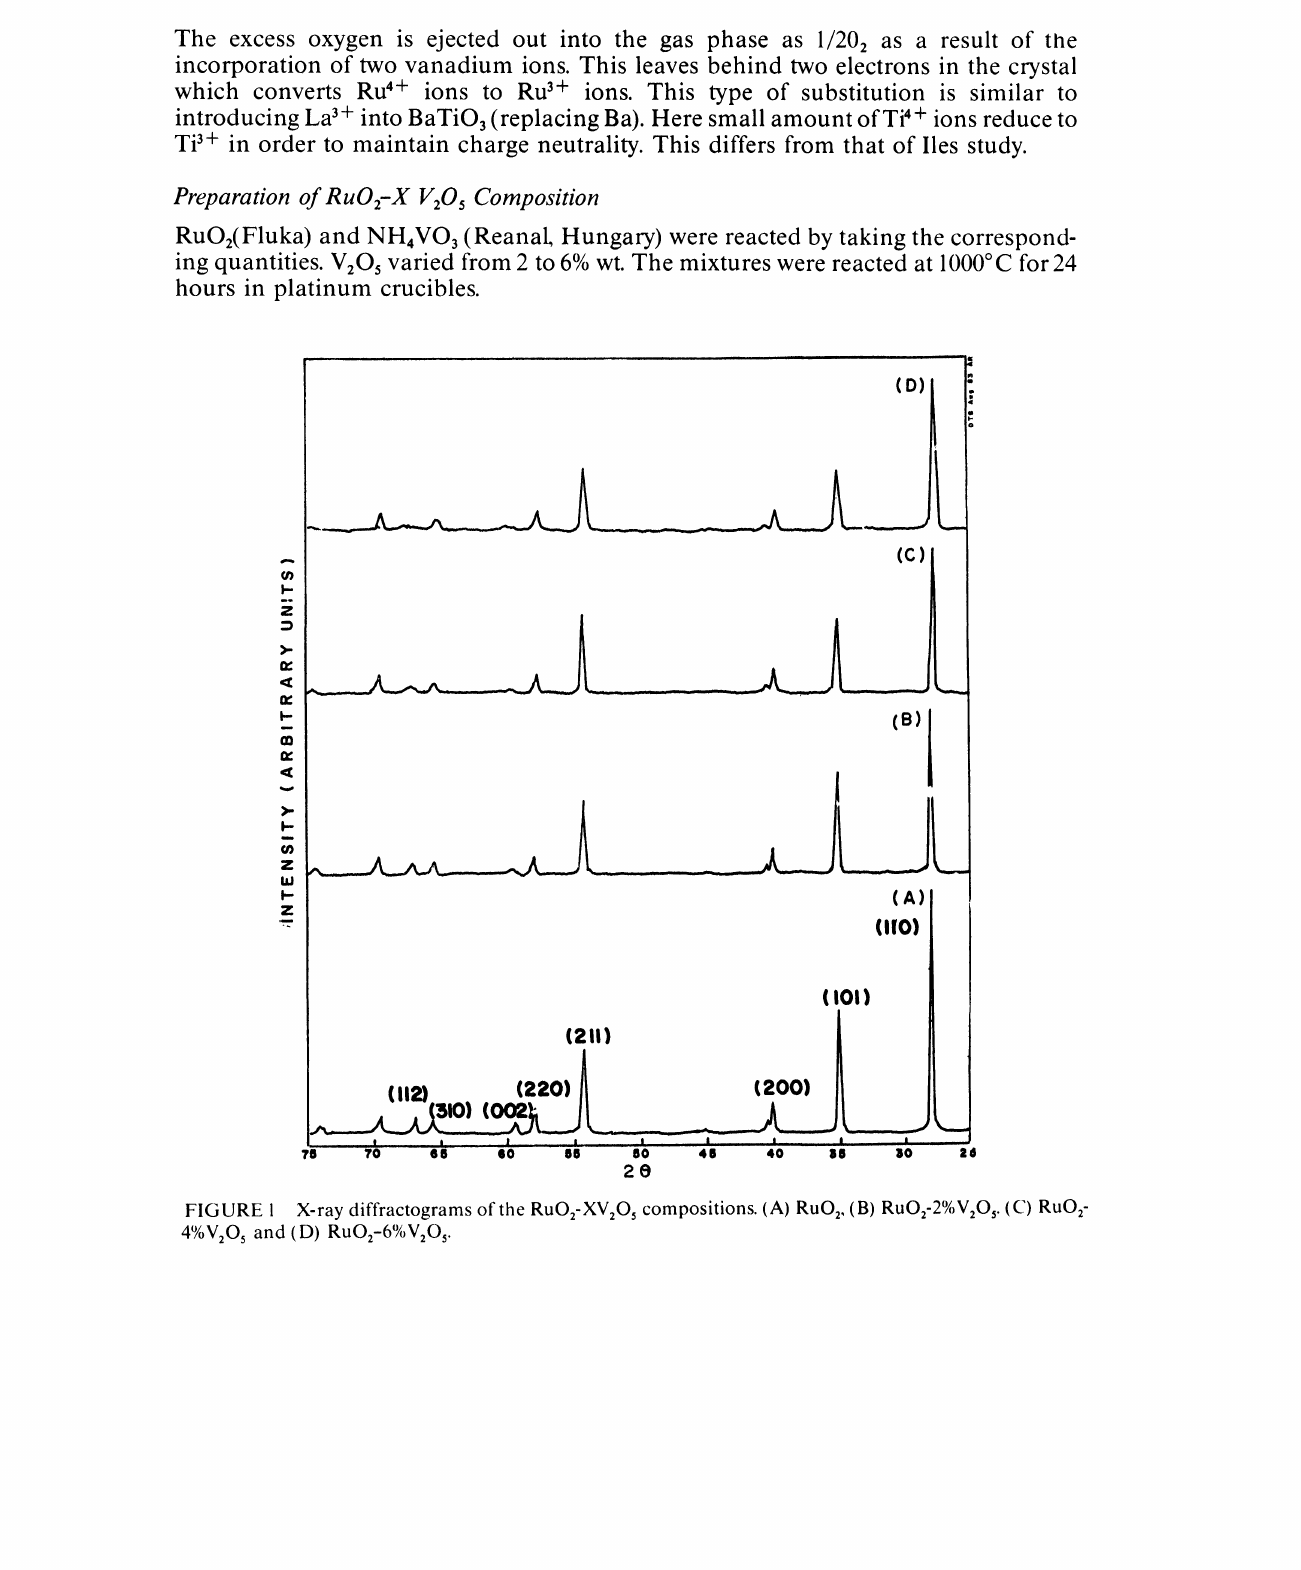
X-ray diffractograms ofthe RuOz-XV205 compositions. (A) RuOz,(B) RuO2-2%V2Ov (C) RuO- 4%V2Os and (D)